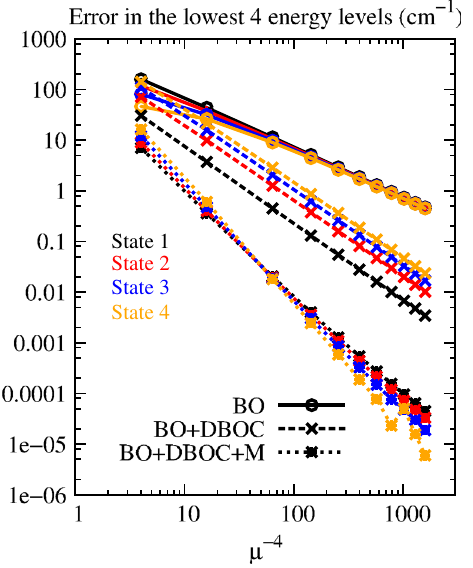
FIG. 8. Error between the four lowest eigenvalues of the full Hamiltonian and the BO approximation (solid lines with circles); the BO approximation corrected by adding the diagonal BO correction, BO þ DBOC (dashed lines with crosses); and the BO approximation corrected by adding the diagonal BO correction and the position-dependent mass, BO þ DBOC þ M (dotted lines with squares). The results are shown as functions of the inverse mass ratio μ − 4 . As in Fig. 7, high precision is achieved when position-dependent mass corrections are taken into